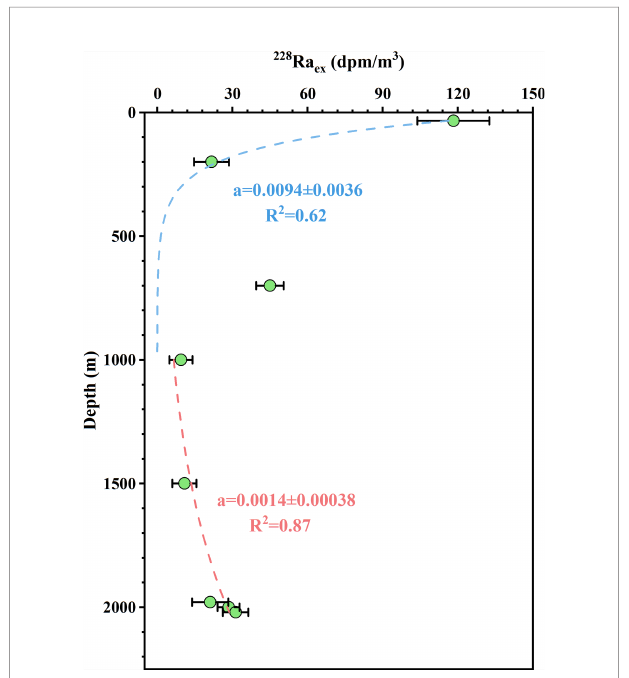
FIGURE 9 | Plots of the excess 228 Ra activities in the vertical pro fi le of station J6 of June 2015. Dashed lines represent the best- fi t exponential curve through the relationships between 228 Ra ex activity and water